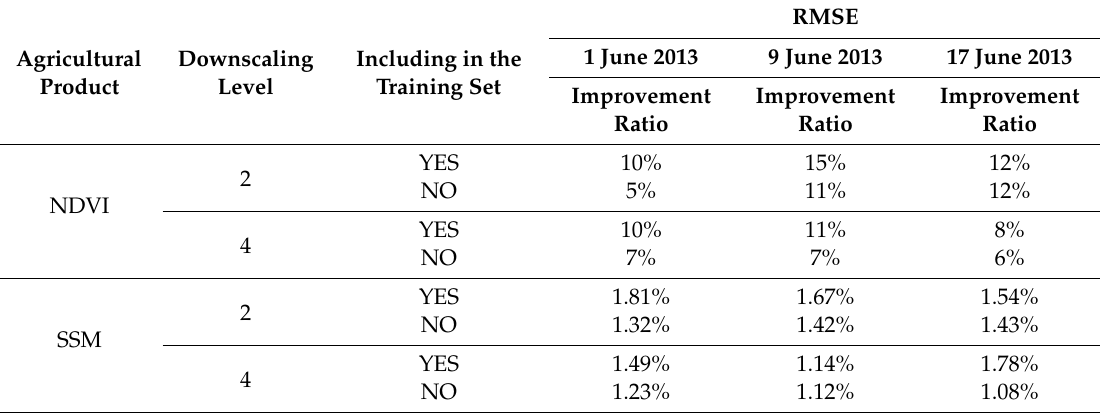
Table 2. Root mean squared error (RMSE) for testing the performance of downscaling scheme in derivation of direct (NDVI) and indirect (SSM) agricultural products. High-resolution AggieAir products are considered as the